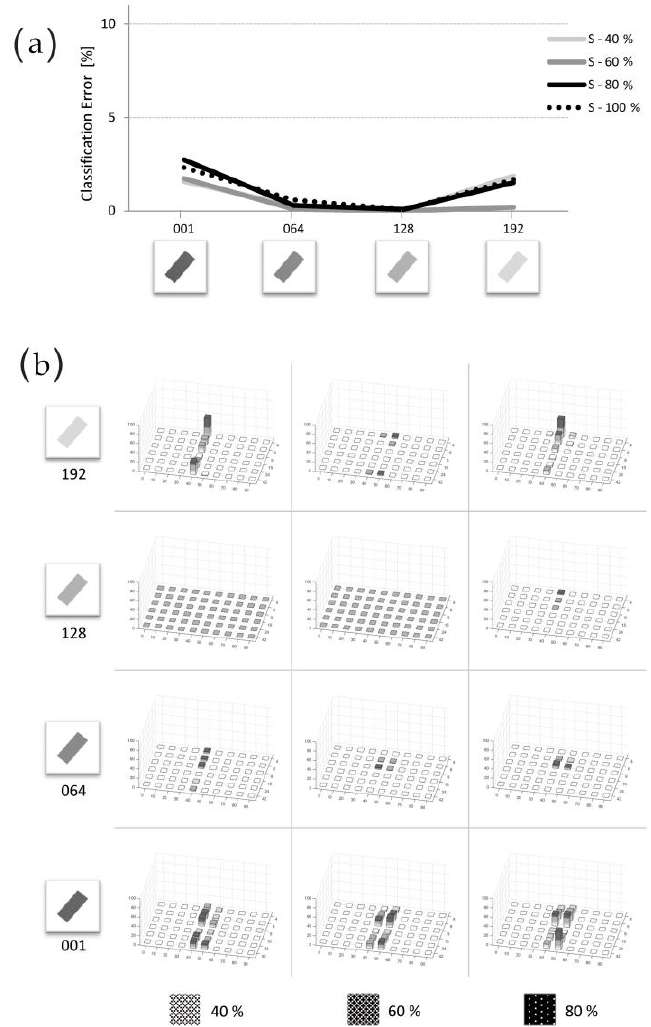
Figure 7. Textured Bars on uniform Background: Small granularity texture. Results of the second group of tests, in which HMAX was assessed when working on textured elements on uniform background. Results here presented refer to the Small granularity texture (1 pixel in diameter). ( a ) Mean values for the twelve experimental conditions (4 Luminance × 3 Density conditions). The three texture densities are represented by three solid lines (80%, 60% and 40%); the dotted line reports the result from previous tests (uniform filling is equal to 100% density; some values are obtained by interpolation). The four Luminance conditions are reported on the x-axis (respectively 001, 064, 128 and 192 #Lum). Results show that also in this case, HMAX provides best results with mid-range Luminance Bars. ( b ) Detailed results for the twelve di ff erent Texture conditions (4 Luminance—in row, and 3 densities—in column). In each histogram, X and Y axes report respectively the ten orientations and the six sizes characterizing each item, as previously presented in Figure 3.